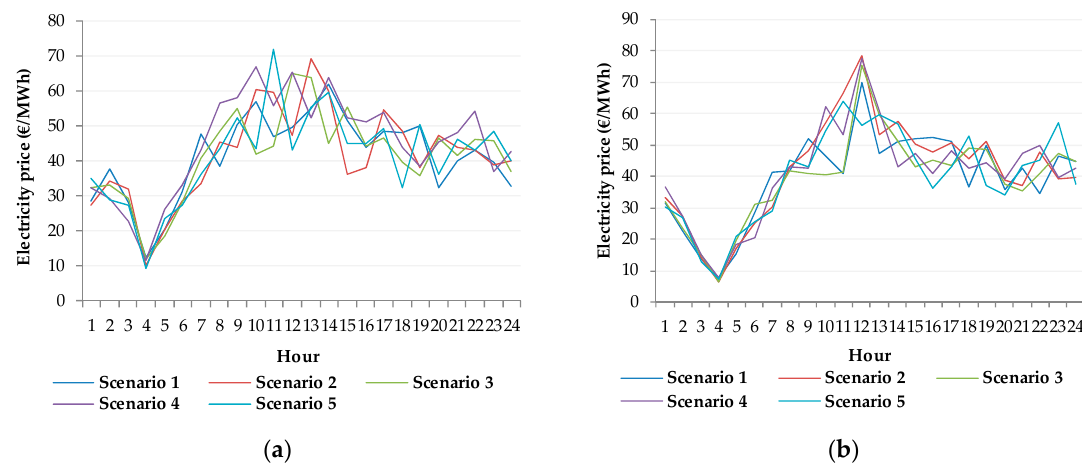
Figure A2. Five electricity market price scenarios: ( a ) day-ahead price scenarios; ( b ) real-time price scenarios.